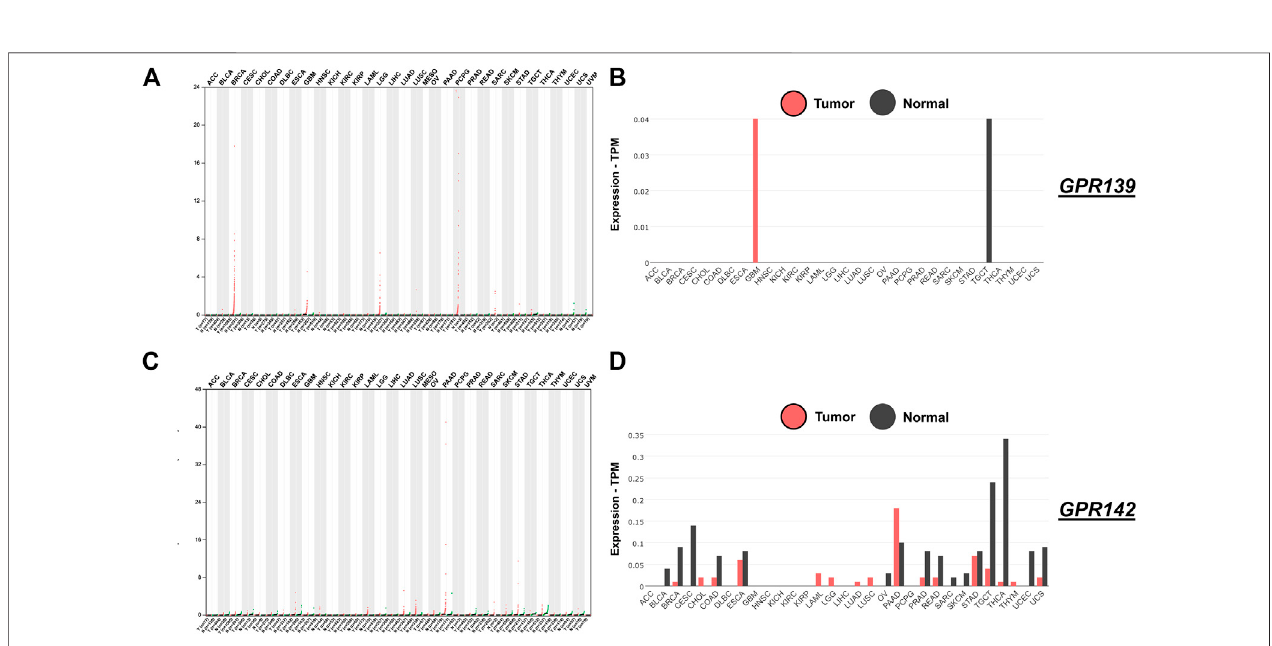
FIGURE2|Expressionof GPR139andGPR142inpan-cancerfromanalyzedTCGAdata. Panel(A) GPR139expressionbreakdown; Panel(B) GPR139tumor and normal expression breakdown; Panel (C) GPR142 expression study; Panel (D) GPR142 tumor and normal expression breakdown.